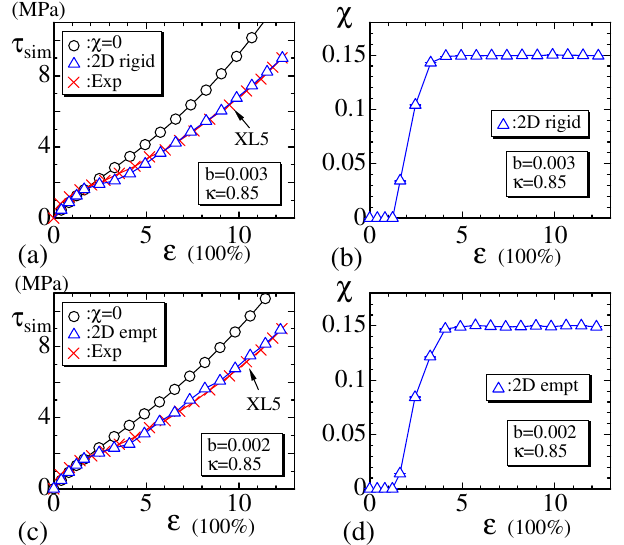
Figure 9. ( a ) The stress τ sim vs. strain ε obtained by the 2D rigid model for the experimental data XL5 ( × ) and ( b ) the corresponding χ vs. ε ; ( c ) τ sim vs. ε obtained by the 2D empty model and ( d ) the corresponding χ vs. ε . In both (a) and (c), the symbol ( (cid:13) ) denotes the data without crystallization obtained by assuming the same values of parameters b and κ assumed for the data ( (cid:52)